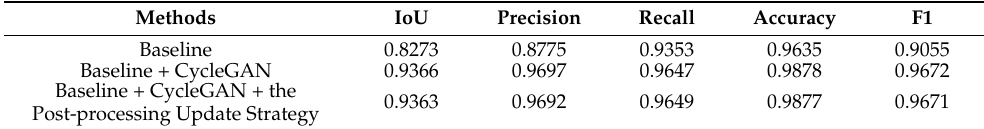
Table 8. Ablation experiments of the proposed update algorithm on the Wuhan University building change detection dataset.